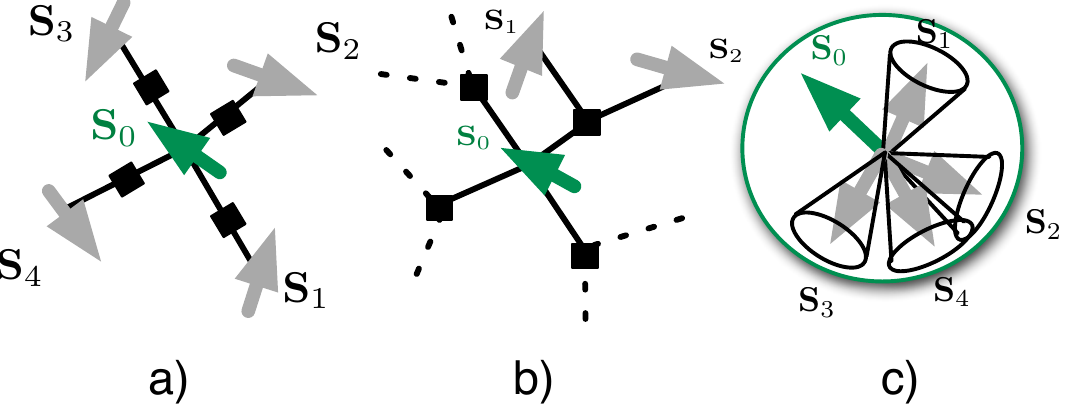
Figure 2: A schematic figure of the model. Panel a) is for the cases of p = 2 and b) is for the case of p = 3-body interaction on a graph with connectivity c = 4. Vectorial spins with M components, in this example M = 3 (Heisenberg spins), are put on the vertexes of a lattice or a graph as shown in the left panel a). The filled square represents the interaction nodes each of which connects a set of p spins on the vertexes (variable nodes) interacting with each other. For the hardcore potential given by Eq. (224) the spin S in panel c) is excluded from the cones around each of 0 the neighboring spins S , S , S . (Note that, for instance, S and S can overlap if they 1 2 3 2 4 are not directly connected by a link). The size of the cones grows with decreasing the parameter δ . Thus the excluding volume effect becomes larger by decreasing δ or increasing the connectivity c